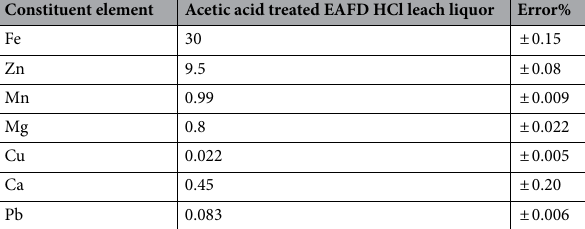
Table 3. Chemical composition of the acetic acid-treated EAFD leach liquor.